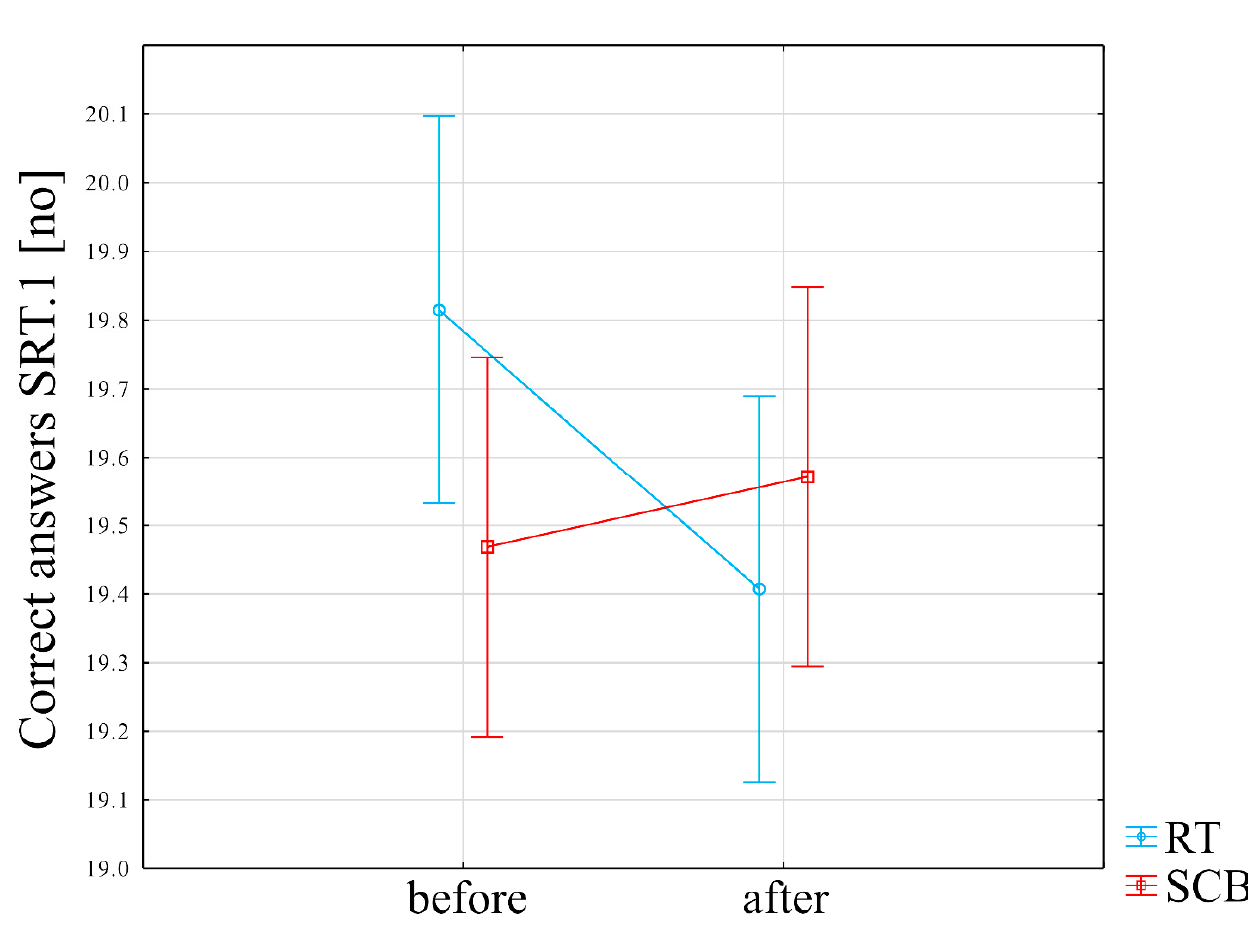
Figure 4. Impact of training programs on correct answers in SRT1 score.